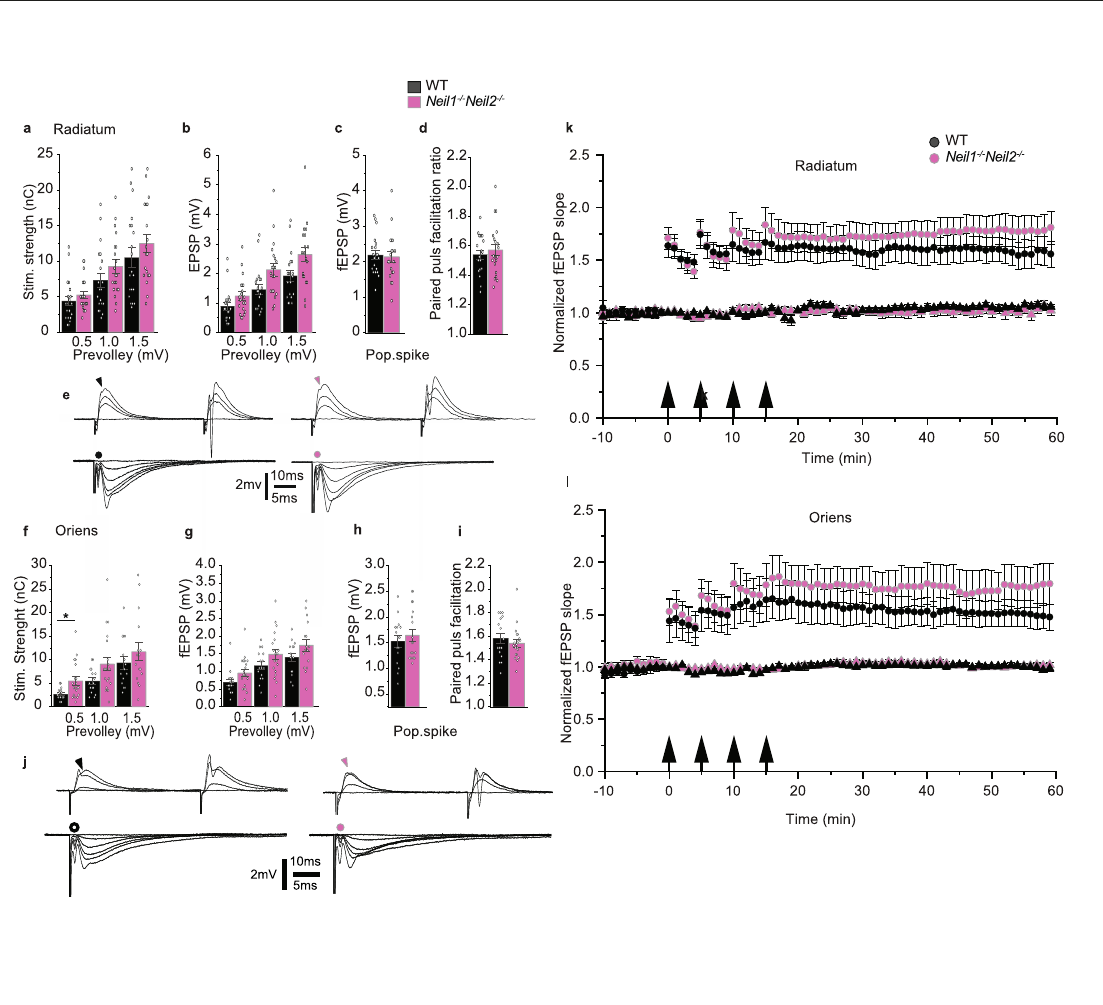
Fig. 3 Reduced axonal activation in stratum oriens of Neil1 − / − Neil2 − / − hippocampus. a – j Synaptic transmission, excitability and paired-pulse facilitation (PPF) in stratum radiatum (SR; a – e ) and stratum oriens (SO; f – j ) of Neil1 − / − Neil2 − / − and WT mice. a , f Stimulation strengths necessary to elicit prevolleys of given amplitudes (0.5, 1.0, and 1.5 mV). b , g fEPSP amplitudes as a function of the same three prevolley amplitudes. c , h The fEPSP amplitudes necessary to elicit a just detectable population spike. d , i PPF ratio from the two genotypes at an interstimulus interval of 50 ms. e , j Recordings from stratum pyramidale (SP) elicited by paired-pulse stimulation (50 ms interstimulus interval). Arrowheads indicate the population spike thresholds in control (black) and Neil1 − / − Neil2 − / − (magenta) mice. Circles indicate prevolleys preceding fEPSPs in control (black) and Neil1 − / − Neil2 − / − (magenta) mice. Each trace is the mean of fi ve consecutive synaptic responses elicited by different stimulation strengths. a – d , f – i Data are shown as mean ± SEM and n values represent total hippocampal slices per genotype (4 – 6 per mouse). Measures in individual slices are indicated with circles superimposed on the mean bars. a , b n = 20 WT for each of the stimulation strengths and 20, 20, 19 Neil1 − / − Neil2 − / − for 0.5, 1.0, and 1.5 mV, respectively. c n = 20 WT and 19 Neil1 − / − Neil2 − / − . d n = 20 for both genotypes. f , g n = 16, 16, 15 WT and 20, 20, 16 Neil1 − / − Neil2 − / − for 0.5, 1.0, and 1.5 mV, respectively. h n = 16 WT and 19 Neil1 − / − Neil2 − / − . i n = 16 WT and 20 Neil1 − / − Neil2 − / − . f * P = 0.019 for prevolley of 0.5 mV, by linear mixed model analysis. k , l Normalized and pooled fEPSP slopes evoked in hippocampal slices from WT and Neil1 − / − Neil2 − / − mice in SR ( k ) and SO ( l ). The tetanized pathways are shown as circles and the untetanized control pathways are shown as triangles. Arrows indicate time points of tetanic stimulation. Data are shown as mean ± SEM and n-values represent total hippocampal slices per genotype (4 – 6 per mouse). k n = 10 WT and 11 Neil1 − / − Neil2 − / − l n = 9 WT and 8 Neil1 − / − Neil2 − / −